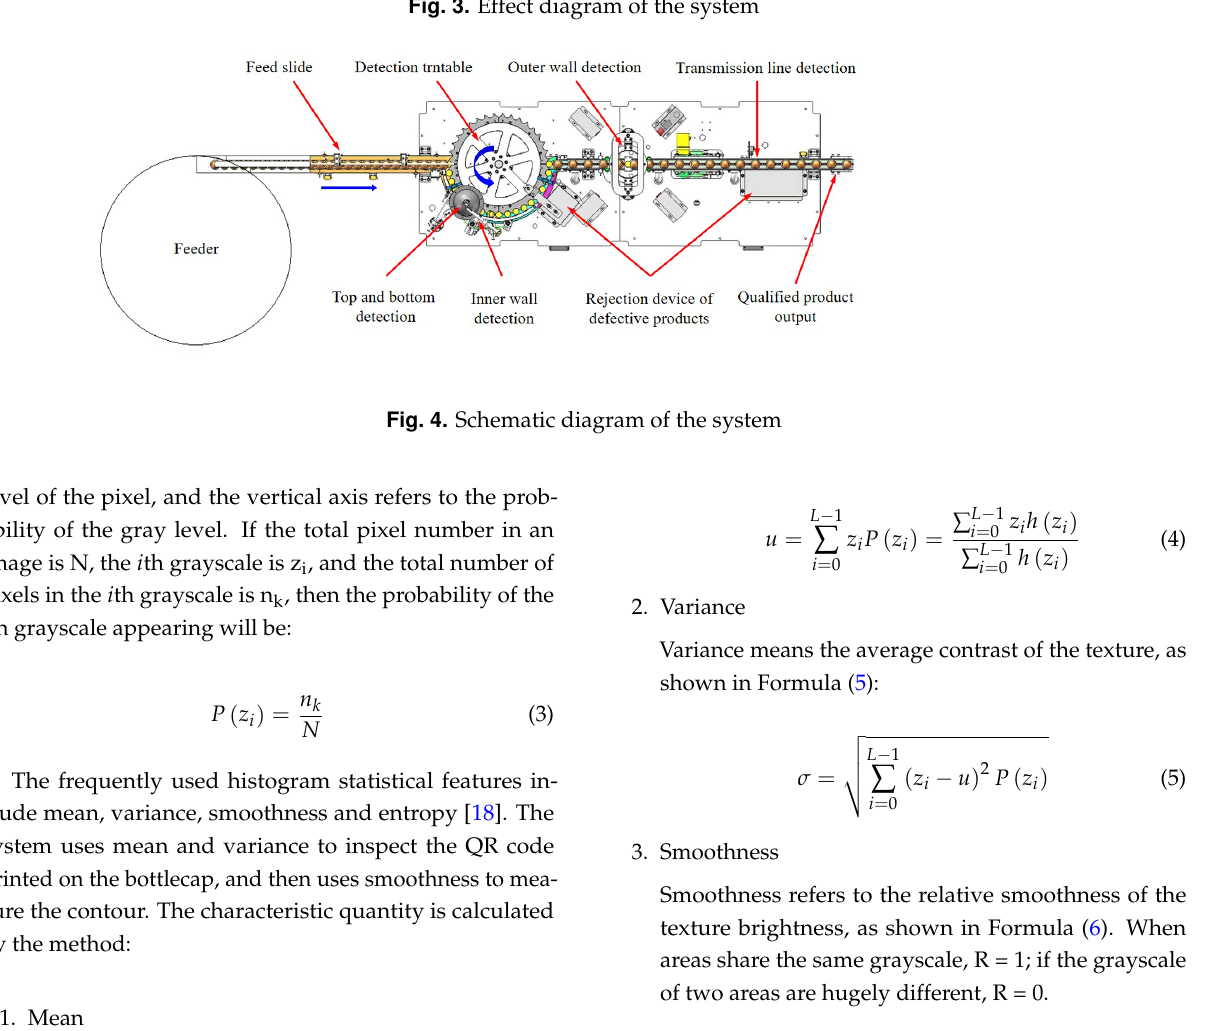
Fig. 3. Effect diagram of the system